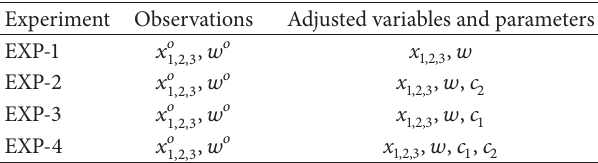
Table 1: Default values and values used in OSSE of the model parameters.